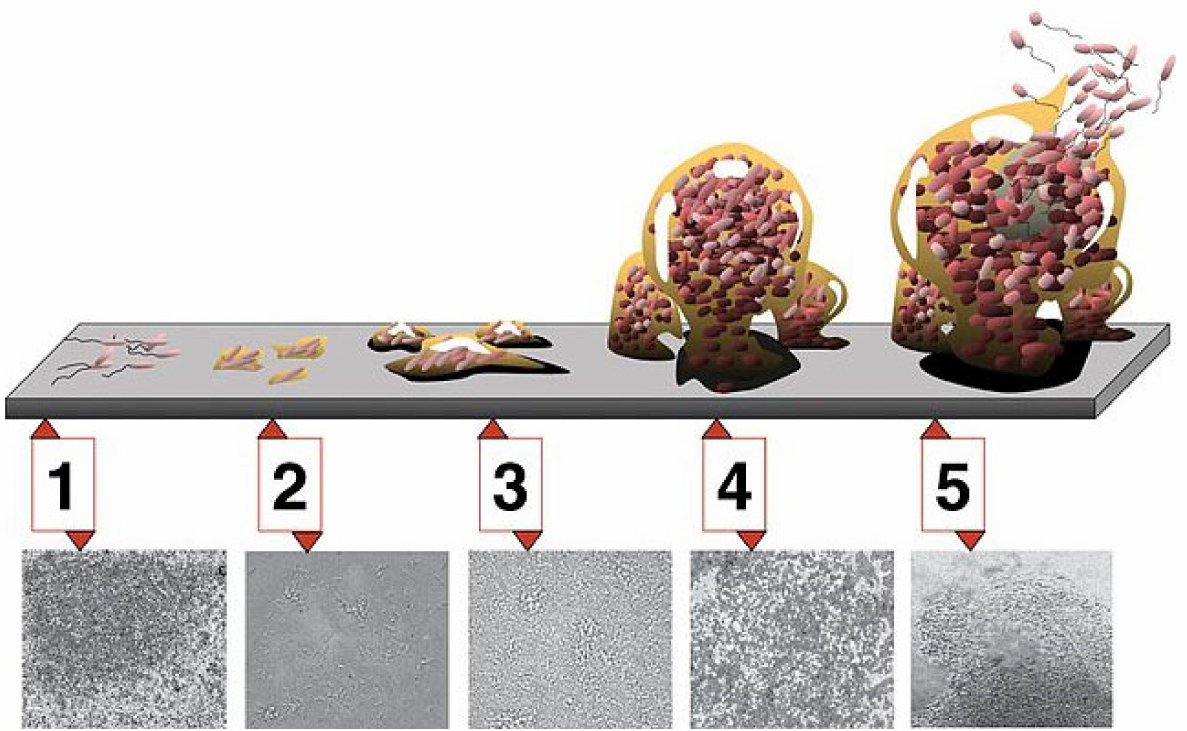
Figure 1. Stages in the development of a biofilm. Stage 1 involves adherence, stage 2 involves attachment and replication, stage 3 involves microcolony formation, stage 4 involves the production of the matrix with biofilm formation, and stage 5 involves partial dispersion of the biofilm, with the free-floating bacteria potentially forming new biofilms